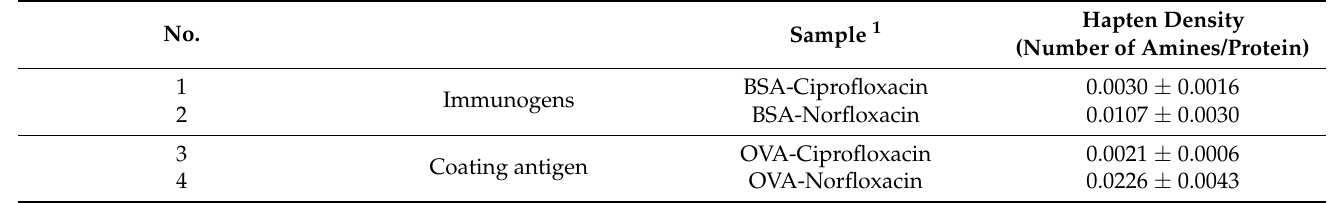
Table 1. Hapten density of immunogens and coating antigen (ciprofloxacin and norfloxacin conjugated).